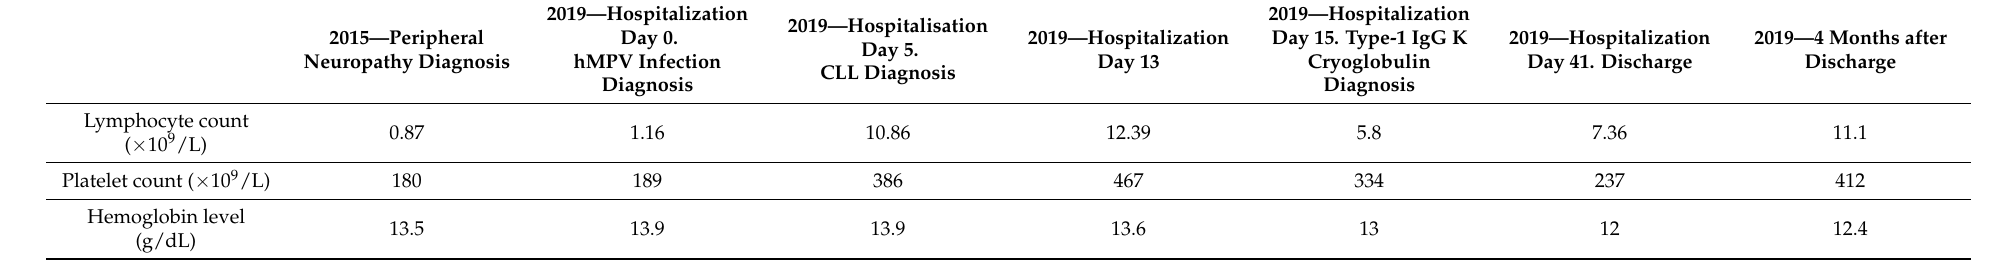
Table 1. Variation in lymphocyte and platelet counts and hemoglobin level. hMPV: human Meta Pneumovirus. CLL: chronic lymphocytic